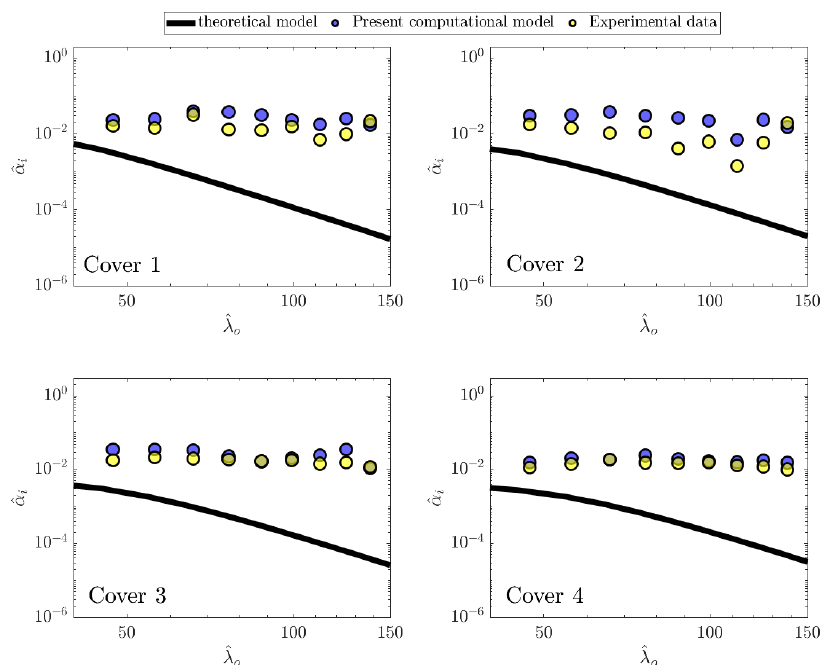
Figure 9. Comparison between computational and experimental decay rates. Experimental and computational data are respectively shown by yellow and blue markers. The black plot shows the predictions of Equation (5). The experimental data are taken from Sree et al. [52].